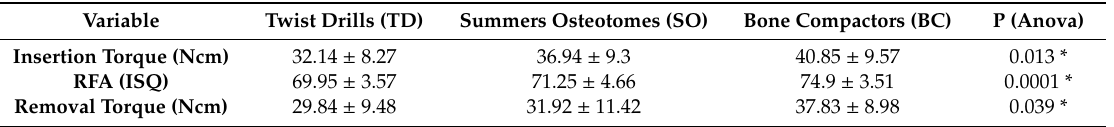
Table 2. Mean and Standard Deviation of Insertion Torque, ISQ and Removal Torque of each group and results of Two-way ANOVA